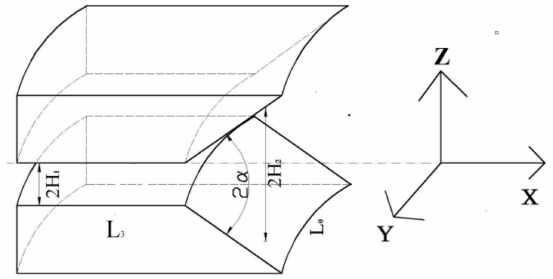
Figure 8. 3D physical model of the